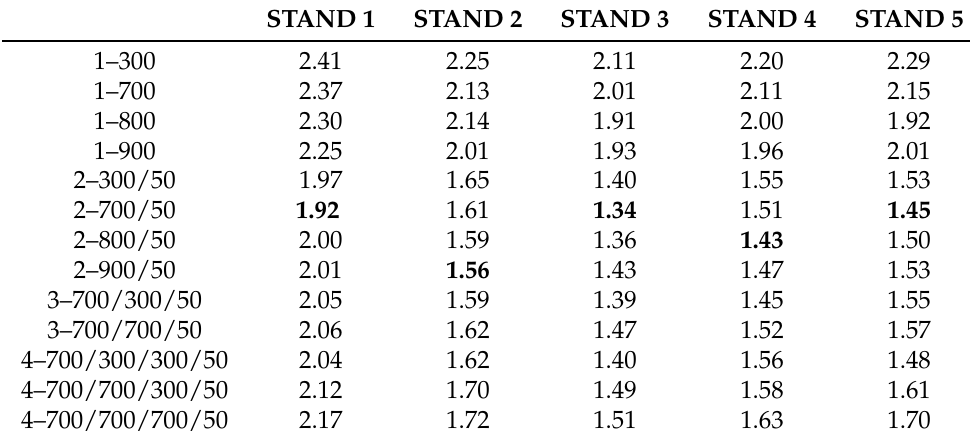
Table 7. Experimental results with neural network architectures for the motor load prediction models (Learning rate: 0.001. Activation function: ReLU.)